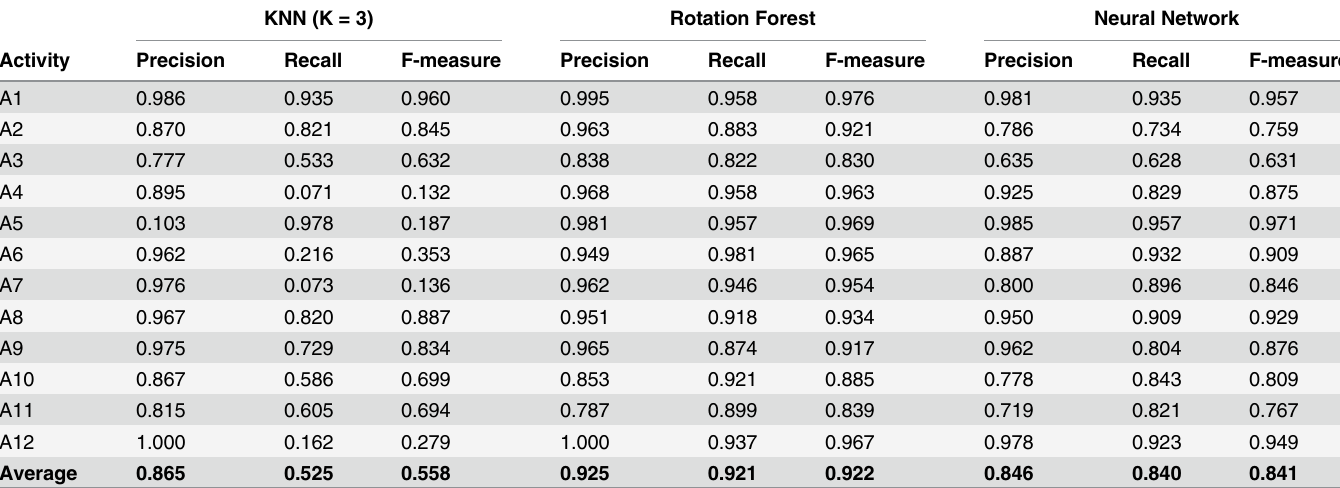
Table 6. Classification results of three classifiers using the acceleration sensor placed on the dominant ankle.